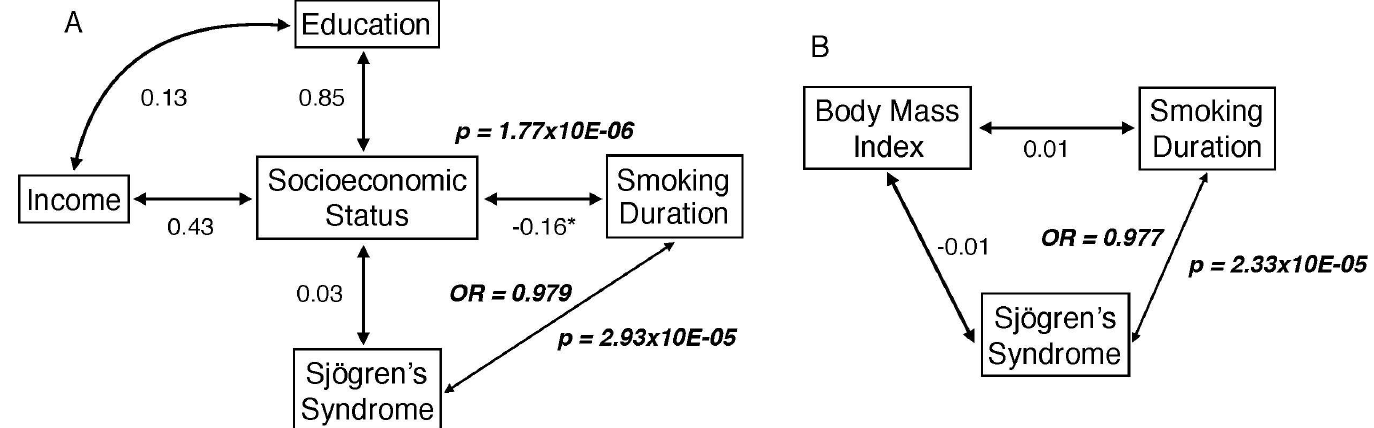
Fig 1. Path analysis model used to estimatethe effect of smoking duration on SS and the role of potential confounding factors. The standardized path coefficients, significantodds ratios (OR) and p-values (in bold) are shown next to each path. A. Effect of smoking durationon SS, conditionalon socioeconomic status; B. Model used to estimate the effect of smoking durationon SS, conditional on body mass index.